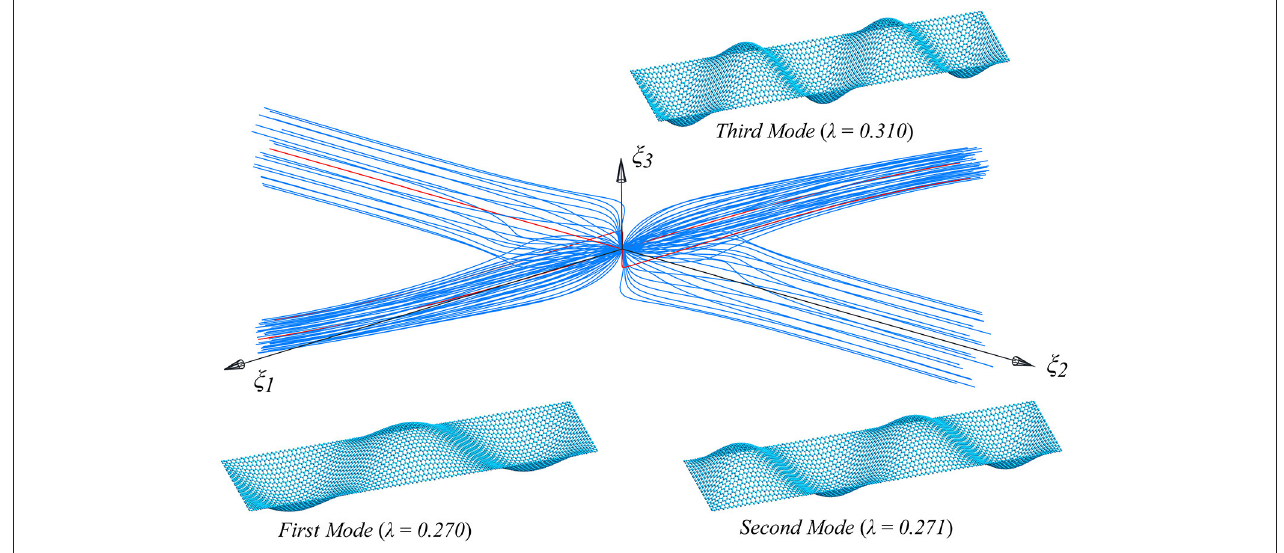
FIGURE 11 | Supported graphene strips under compression in the armchair direction: first three buckling modes and their interaction.